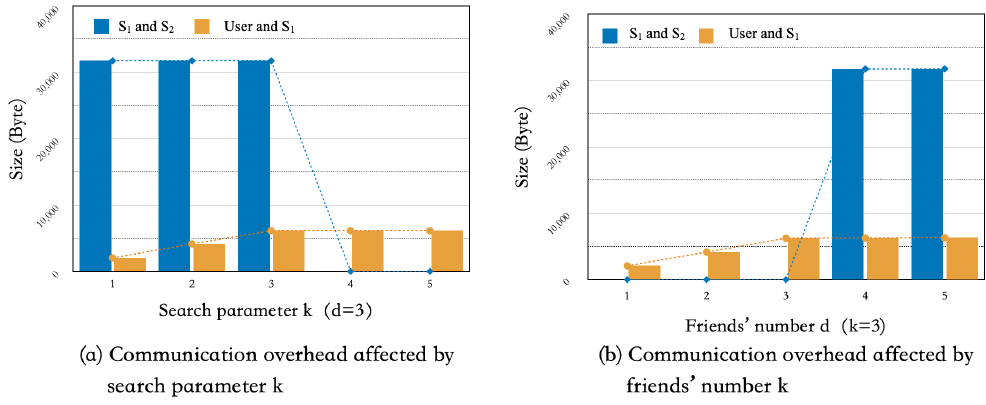
Figure 2. Communication